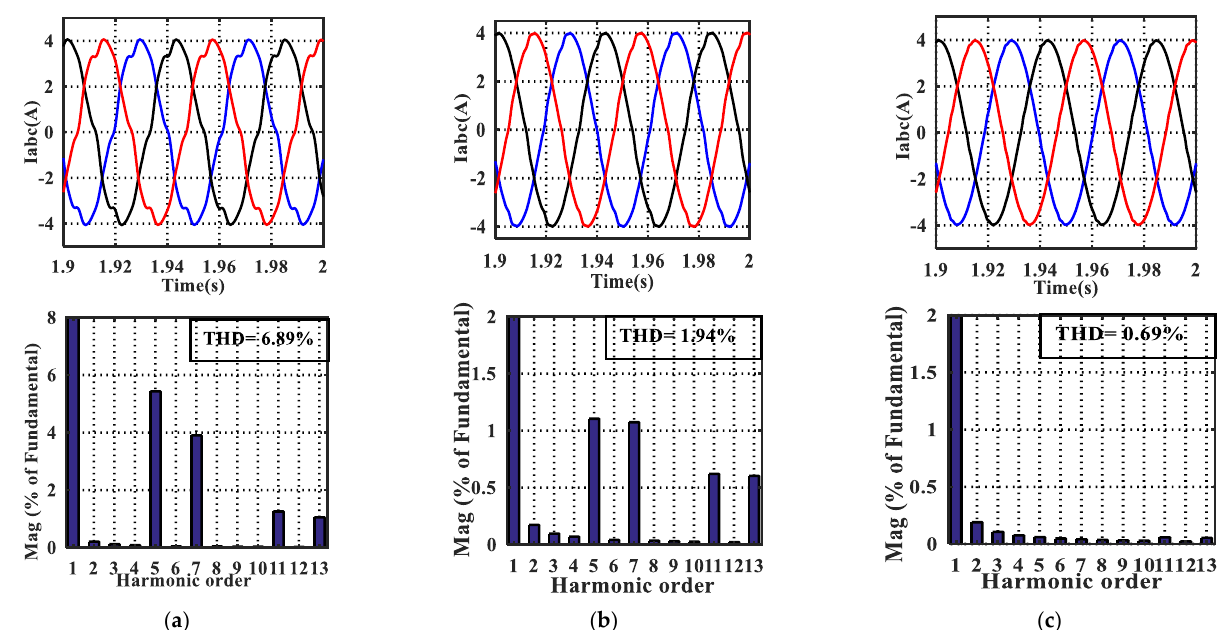
Figure 10. Simulation results of phase current and FFT analysis without load: ( a ) with a PI controller, ( b ) with a PIR controller and ( c ) with the Robust-TDOFR controller. Table 3. Simulation results under the operation of no-load.